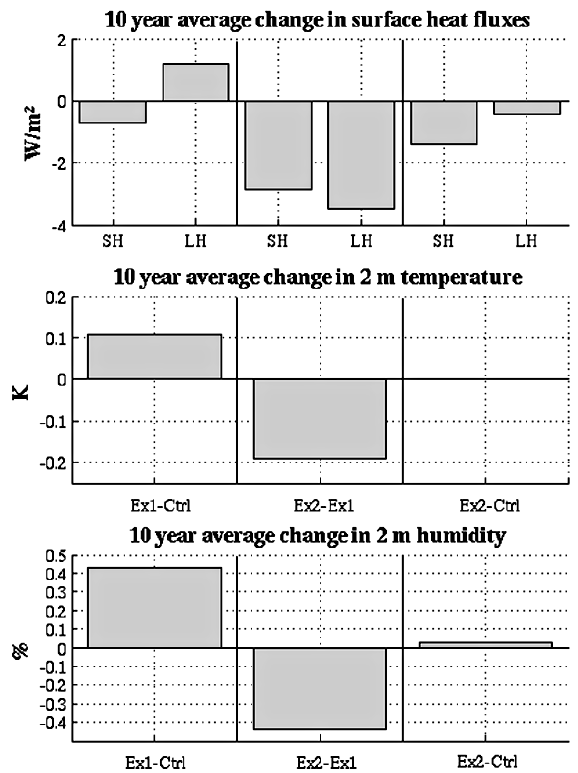
Figure 7. Changes in 10-year averages in surface variables, as av- erages per area of vegetation change only. Left-side bars show veg- etation shift effects of Ex 1 compared to the control run (northward migration of evergreen forest and shrub expansion combined). The middle bars show the effect of mixed forest migration only, given as the difference between Ex 2 and Ex 1. Bars on the right show the effect of all vegetation changes together, averaged over all areas with vegetation changes. Differences in sensible heat flux (SH) and latent heat flux (LH) are shown in the top panel, 2m temperature changes in the middle panel, and 2m absolute humidity changes in the bottom panel. Note that areas of different vegetation shifts are not equal in size, and therefore averages are not